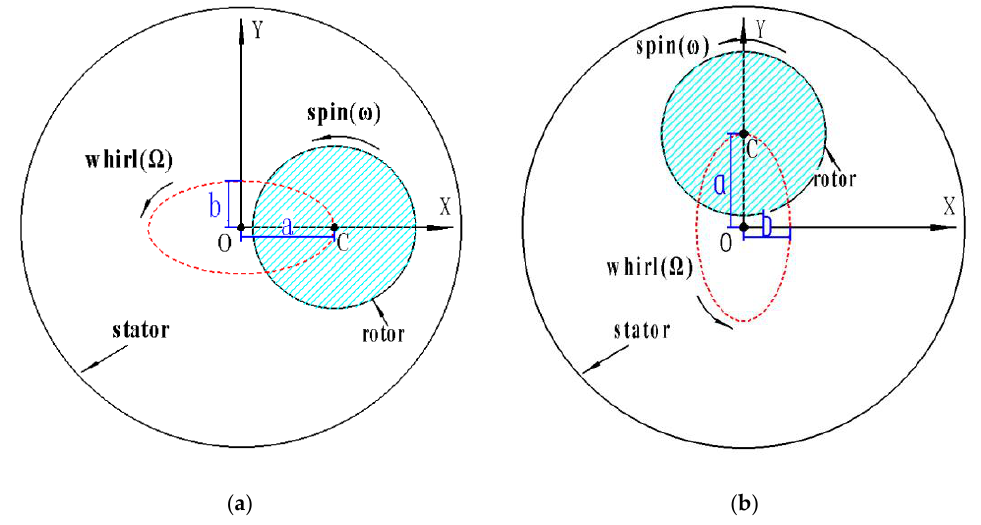
Figure 3. Schematic diagram of the elliptical whirling orbit model at a single frequency for ( a ) the x -direction excitation and ( b ) the y -direction excitation.